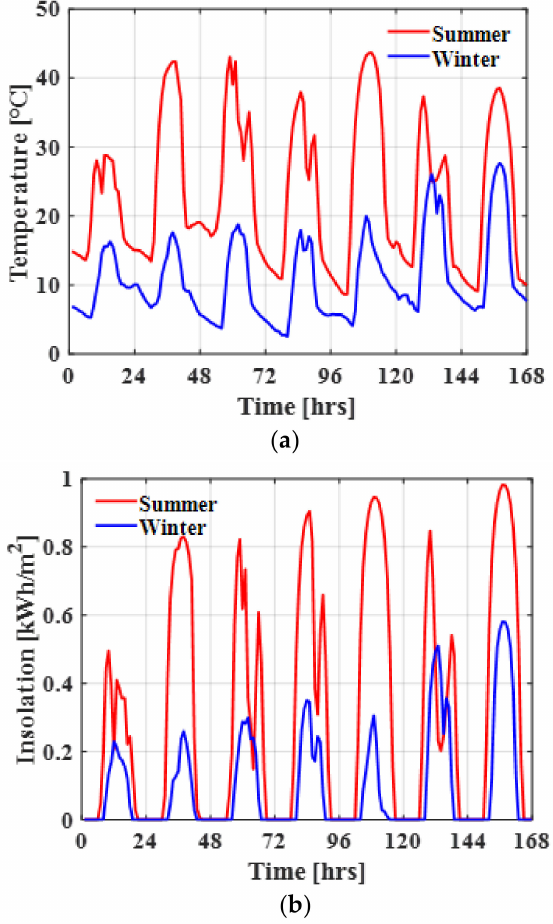
Figure 5. Meteorological data for two sample weeks in summer and winter in urban area South Australia (34.56 S, 138.32 E). ( a ) Ambient temperature. ( b ) Solar insolation